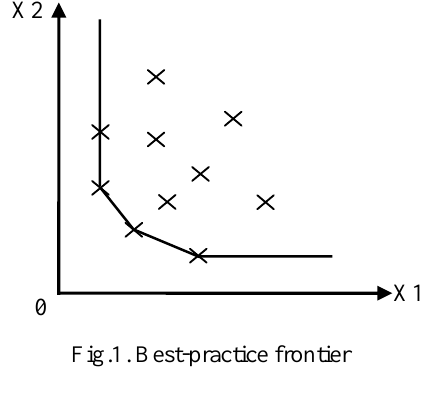
Fig.1. Best-practice frontier